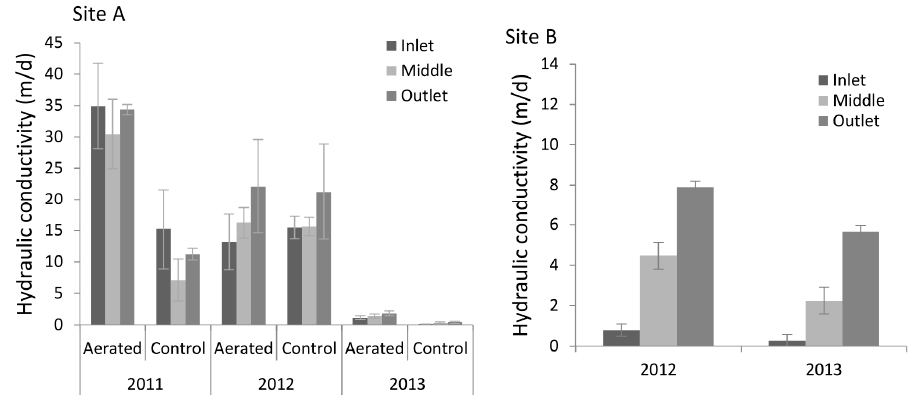
Figure 10. Hydraulic conductivity (m/d) as the beds matured for Sites A and B.